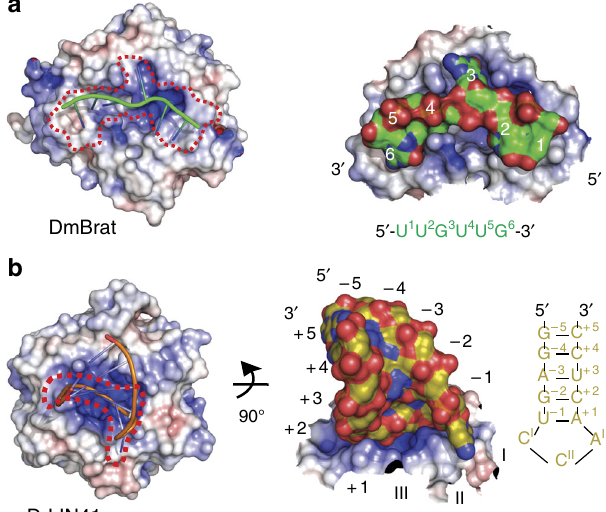
Fig. 8 RNA binding preferences of LIN41 and Brat. a Left: crystal structure of the DmBrat NHL domain in a complex with a single-stranded linear RNA (PDB 4ZLR 17 ). The protein surface is colored by the electrostatic surface potential from – 8 kT/e (red, acidic) to + 8 kT/e (blue, basic) and the RNA is shown as a cartoon. The approximate footprint of the RNA interaction on the protein surface is shown as a dotted red line. Right: magni fi ed view of the RNA-binding site. A fragment of the interacting protein surface is shown and colored as on the left. The RNA is shown in surface mode, with carbon atoms in green and other atoms in standard colors. Nucleotide positions are labeled as in the RNA sequence displayed below. b Left: crystal structure of DrLIN41 in complex with the lin-29A RNA stem loop. The protein surface is colored as in a . Right: magni fi ed view of the RNA- binding site in an orientation rotated by 90°. The RNA stem loop is shown in surface mode, with carbon atoms in gold and other atoms in standard colors. The corresponding RNA sequence is on the